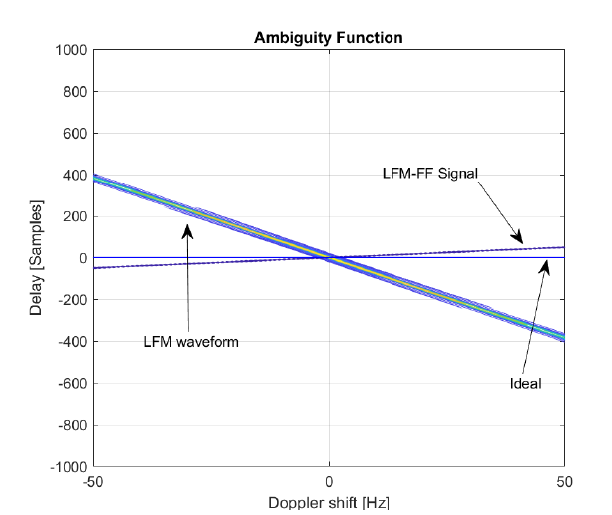
Figure 6. AF of LFM-FF signal: maximum magnitude and time shift. ( a ) Maximum magnitude vs. Doppler shift; ( b ) Time shift vs. Doppler shift.